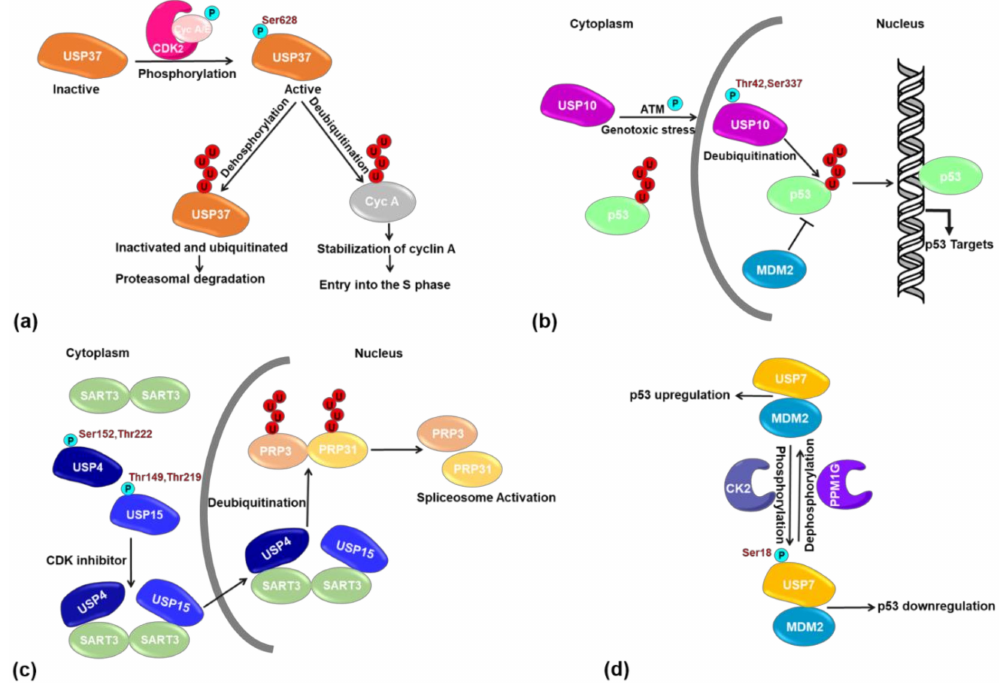
Figure 3. Examples of phosphorylation on various DUBs. ( a ) Phosphorylation of USP37 in G1 / S triggers its full DUB activity. Phospho-USP37 stabilizes cyclin A by removing degradative polyUb, whereas dephosphorylated USP37 can be ubiquitinated and undergoes proteasomal degradation in late mitosis [17]. ( b ) Phosphorylated USP10 translocates into the nucleus where it deubiquitinates p53 and inhibits Mdm2-induced p53 degradation [49]. ( c ) USP15 and USP4 dephosphorylation lead to their interaction with SART3, which in turn allows DUB translocation into the nucleus and the regulation of spliceosomal function [92]. ( d ) CK2-mediated phosphorylation stabilizes USP7, resulting in Mdm2 stabilization and p53 downregulation. USP7 dephosphorylation by PPM1G destabilizes USP7 resulting in Mdm2 degradation and upregulation of p53